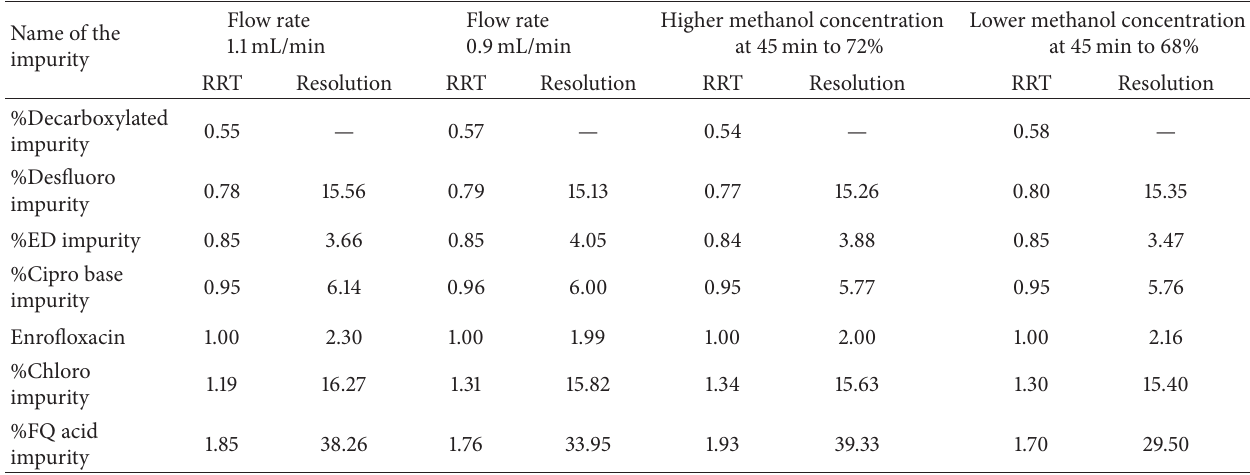
Table 10: Robustness results (flow rate and minor component change